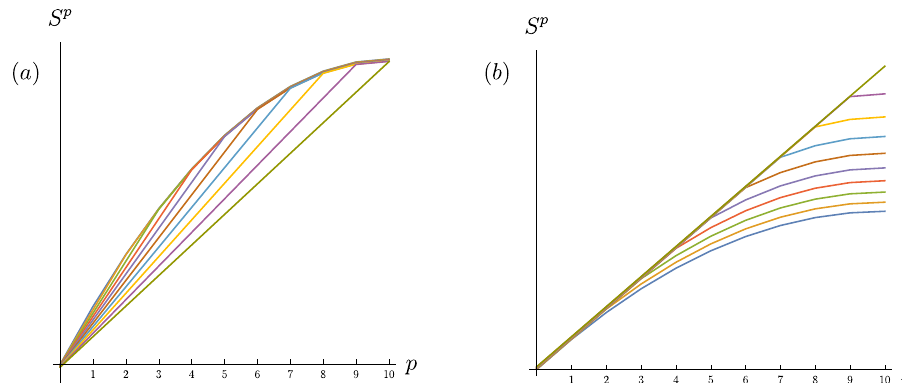
(cid:1) (cid:3) ¼ 10 extremal graphs; their plots of S p versus b c ¼ S 10 and b normalized to fi x S 1 .